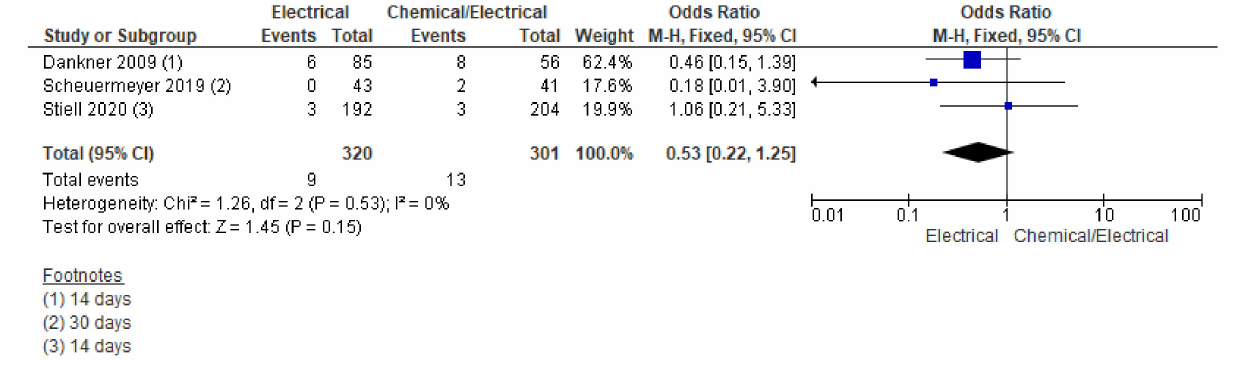
Figure 5. Forest plot showing readmission rate across electrical and chemical followed by electrical cardioversion group using fixed effect model [2,3,11].